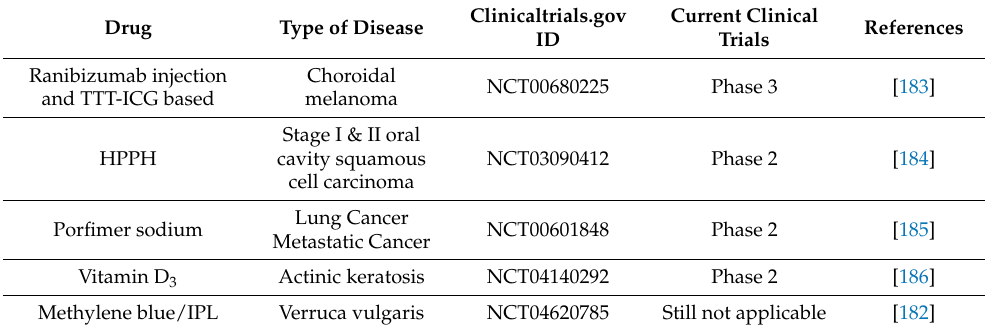
Table 5. Exogenous contrast agents with phototherapeutic properties in clinical trials. Clinicaltrials.gov Drug Type of Disease